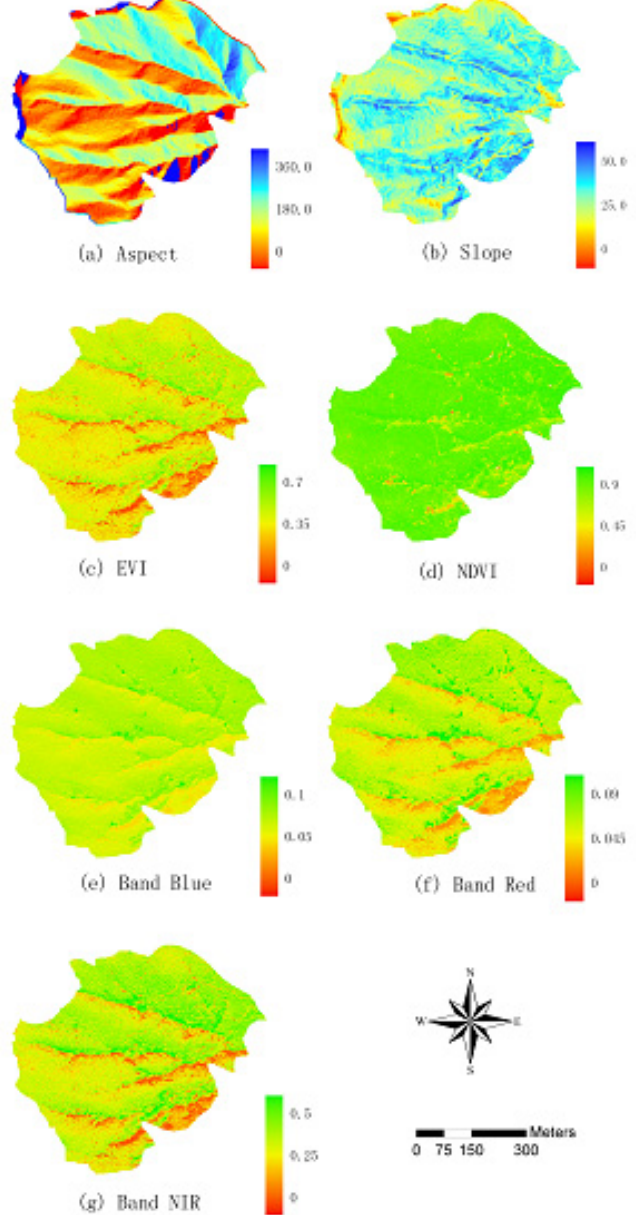
Figure 2. The spatial distribution of aspect, slope, single channel reflectances (blue, red and near-infrared), EVI and NDVI in the study